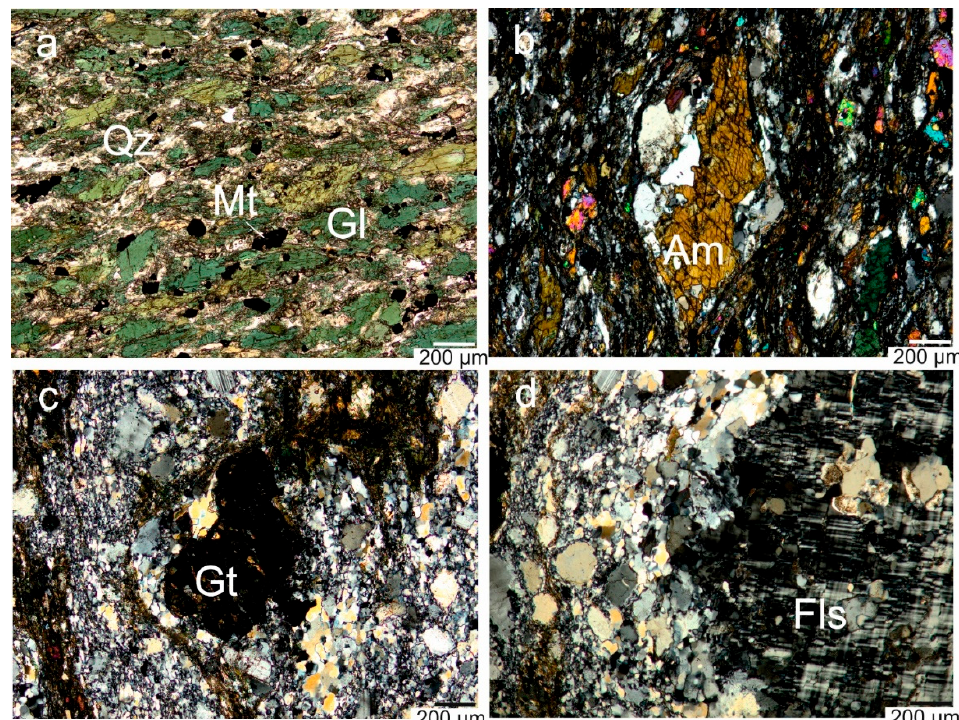
Figure 5. Microscopic observations of thin sections: ( a ) glaucophane-quartz-magnetite schist (Gl-Qz-Mt) after pseudotachylyte of basic composition (type II) in sample KL-9 (plane polarized light); ( b–d ) large grains of minerals in a quartz-feldspar aggregate that replaces pseudotachylyte of dacite composition (type I): amphibole (Am) in sample KL-17 from a vain ( b ), garnet (Gt), and potassic feldspar (Fls) ( c and d , respectively) in sample KL-3 from a wedge (crossed polarized light). 200 μ m scale bar shown in each microphotograph.